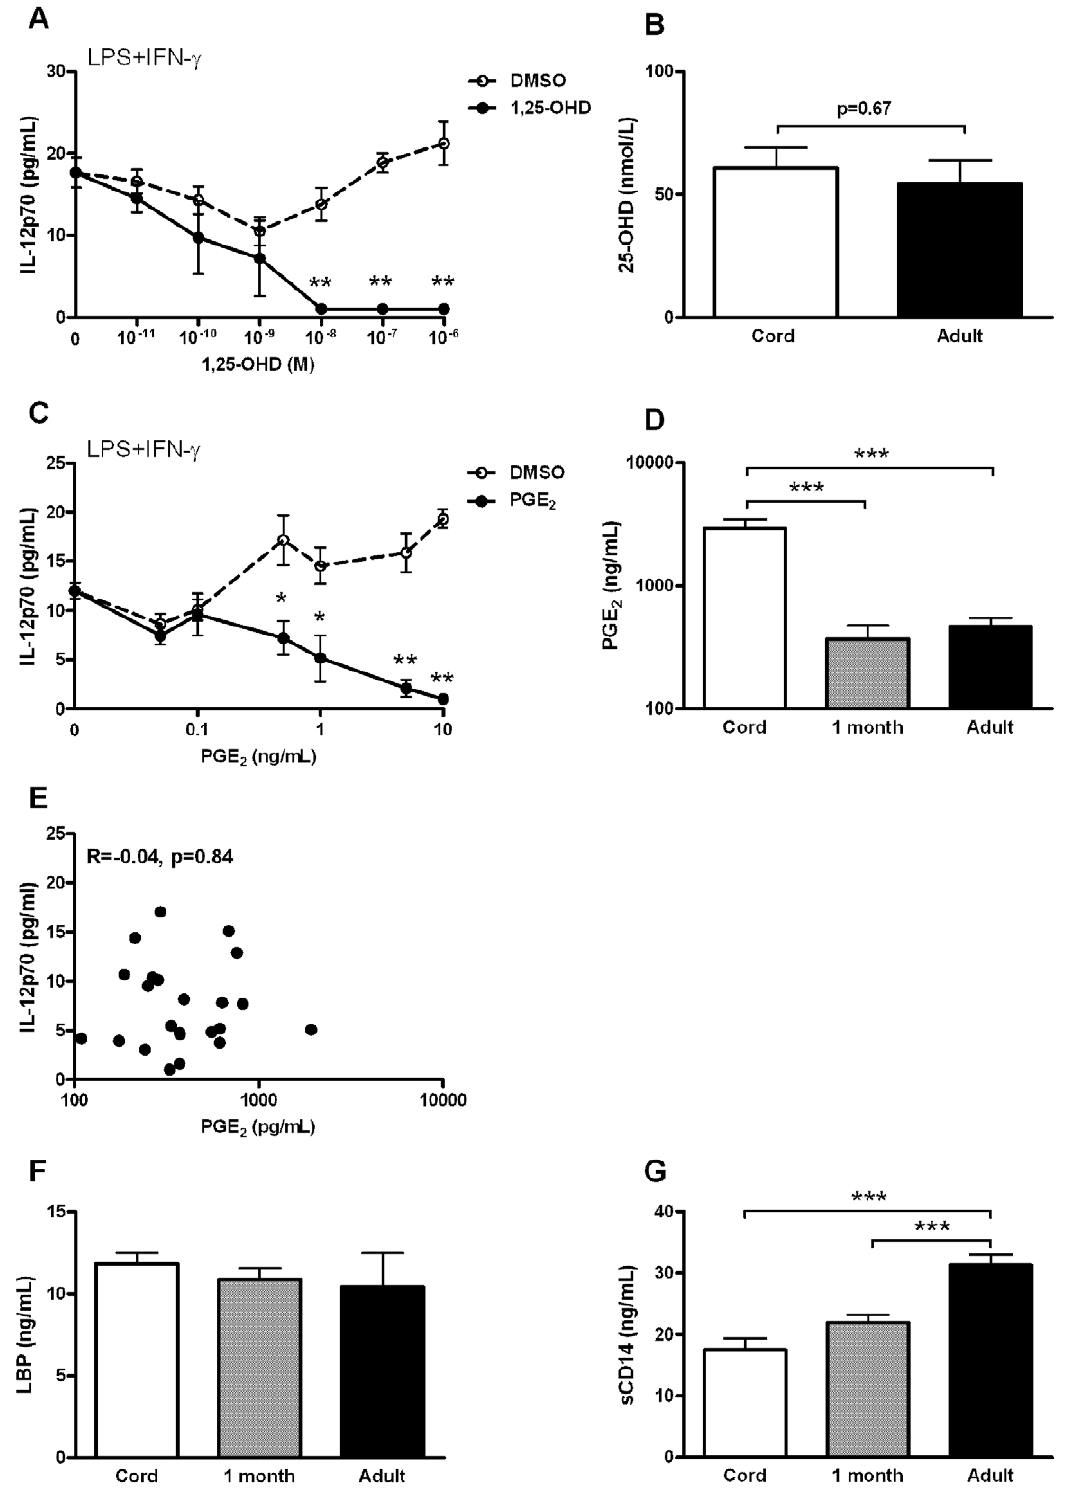
Figure 6. Suppression of TLR4-mediated IL-12p70 and induction of IL-10 by neonatal plasma are not due to prostaglandin E 2 , vitamin D, soluble CD14 or LBP. A; TLR4-mediated production of IL-12p70 by adult PBMC stimulated in the presence of increasing concentrations of 1,25-dihydroxyvitamin D (1,25-OHD). B; Concentrations of 25-hydroxyvitamin D (25-OHD) in cord blood plasma and adult plasma, determined by EIA. C;, TLR4-mediated production of IL-12p70 by adult PBMC stimulated in the presence of increasing concentrations of prostaglandin E 2 (PGE 2 ). D;, Concentrations of PGE 2 in cord blood plasma and adult plasma. E;, Correlation between plasma concentration of PGE 2 and its capacity to suppress TLR4-mediated IL-12p70 production. F–G; Concentrations of LBP (F) and sCD14 (G) in cord blood plasma and adult plasma. Data are presented as the mean 6 SEM of five to eight individual plasma donors and are representative of three independent experiments. In panel E, each dot represents one individual plasma donor. *; p , 0.05, **; p , 0.01; ***; p , 0.001.